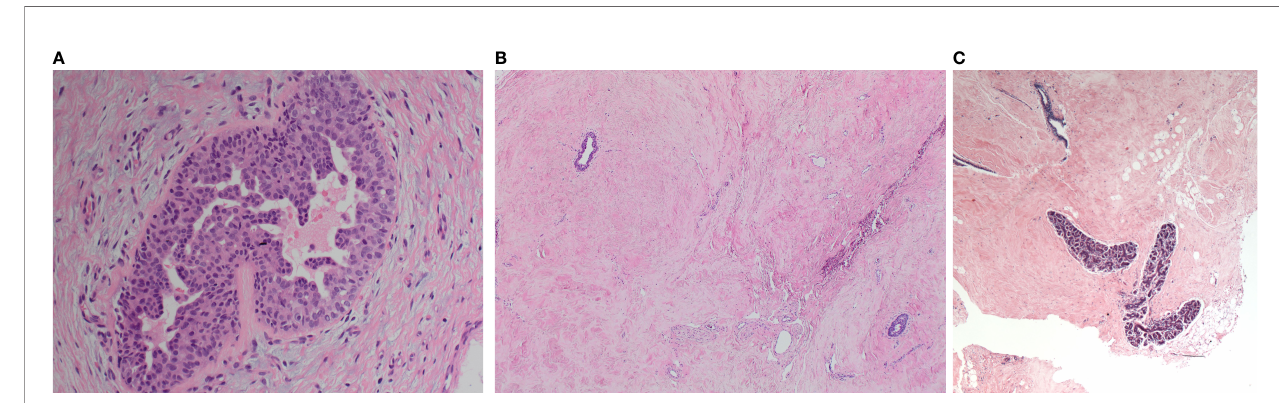
FIGURE 1 | Morphological appearances of the male breast gynaecomastia cases. (A) Florid gynaecomastia showing a mammary duct with micropapillary epithelial hyperplasia. The surrounding stroma is cellular and oedematous. (B) Late ( fi brous) gynaecomastia: mammary ducts with minimal hyperplasia within a fi brosed stroma. (C) Well-developed mammary lobules were occasionally observed.